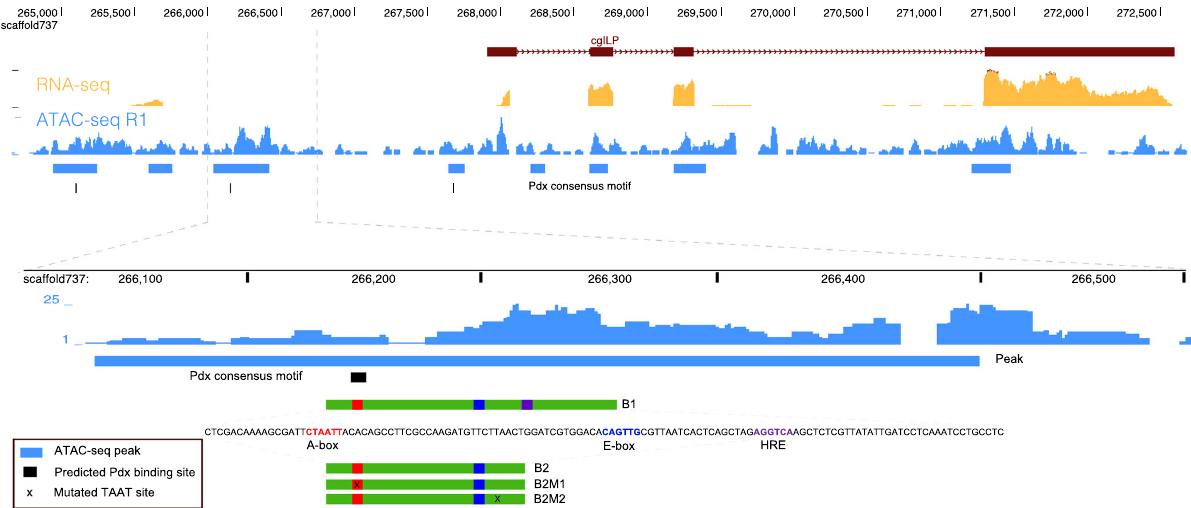
Fig. 4 Potential transcription factors binding sites (A-box, E-box, and HRE) identi fi ed by ATAC-seq peak. A 72 bp region (green box) was used for dual- luciferase assays. Gene structure of cgILP is shown in the top bars, where purple bars indicate exons, and arrows along the line indicate transcriptional orientation. The ATAC-seq peaks are not direct extrapolation of the regions with the highest sequencing signal as the calling process takes into account both replicates, the averaged background over a window, and the shift induced by the library construction